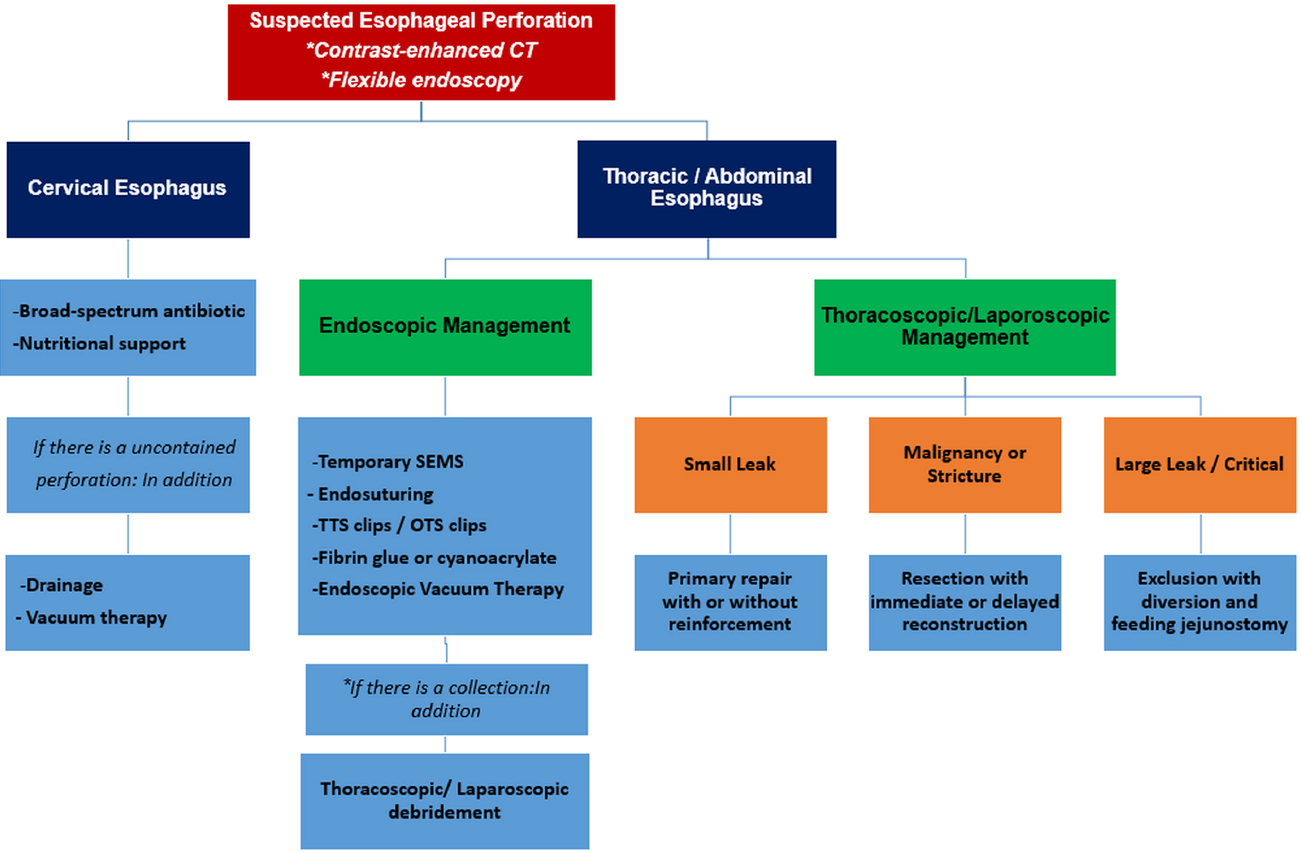
Figure 1. The treatment algorithm in esophageal